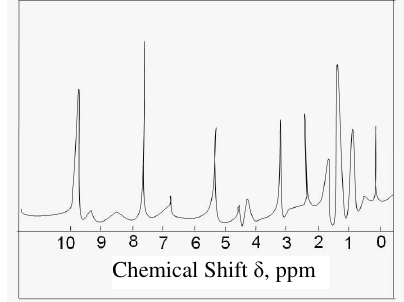
Figure 3. 1 H NMR spectra of 2,4-DHBAMF